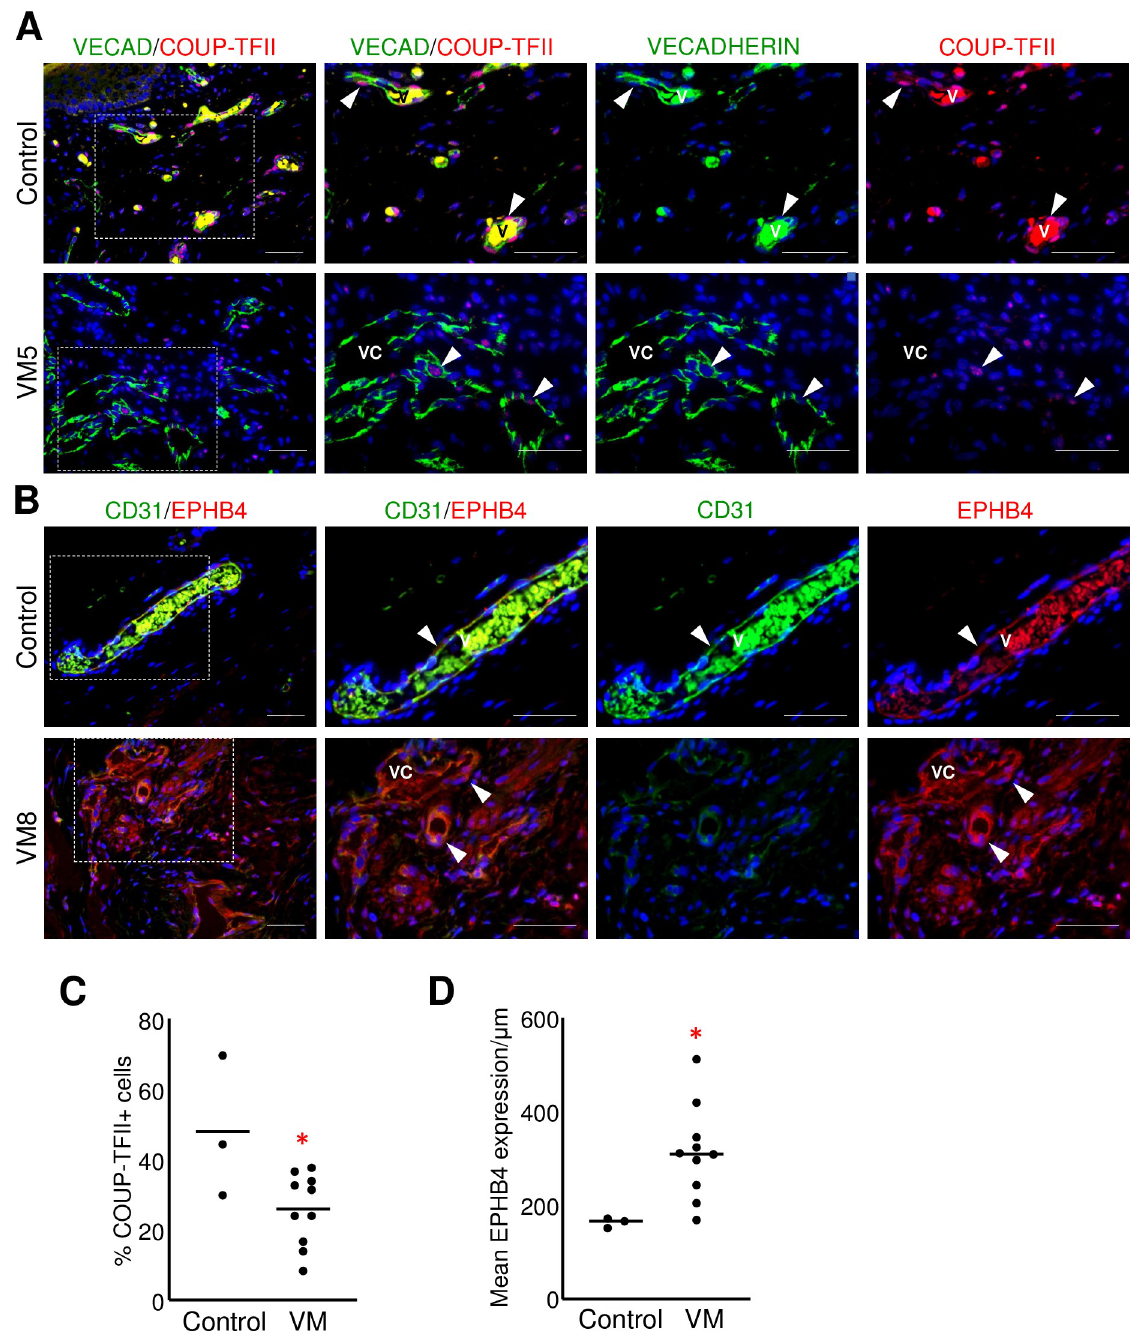
Fig 2. Venous endothelial proteins were altered in VM endothelium. (A) Representative images of VMs and control neonatal dermis co- stained for VECADHERIN (VECAD) and COUP-TFII. White arrowheads mark VECADHERIN+/COUP-TFII+ ECs. (B) Representative sections of VMs and control neonatal dermis co-stained for VECADHERIN and EPHB4. White arrowheads mark CD31+/EPHB4+ cells. (A, B) Boxed areas are enlarged to the right. V-vein, VC-VM channel. Scale bars—50 μ m. V-vein, VC-VM channel. (C) Percent COUP-TFII + ECs in VMs (n = 10) and controls (n = 3). (D) Mean EPHB4 expression normalized by vessel length in VMs (n = 10) and controls (n = 3). (C, D) Bars represent median values, � p < 0.05.